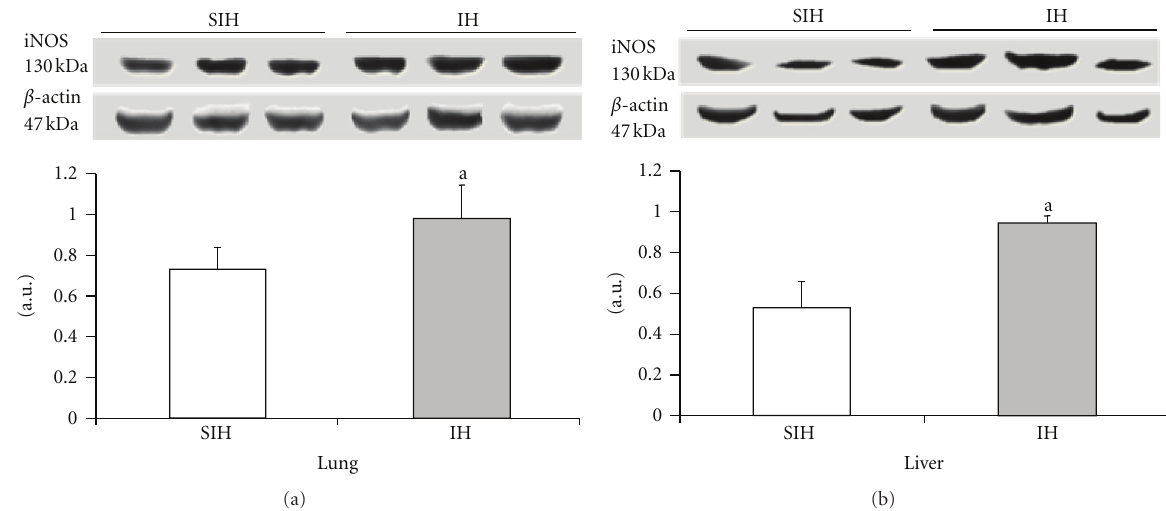
Figure 4: The e ff ect of intermittent hypoxia on the expression of iNOS in the liver ((a), P = 0 . 0091) and lung ((b), P = 0 . 0107). Results are reported as mean ± standard error, n = 6 per group. P value according to Student’s t -test.